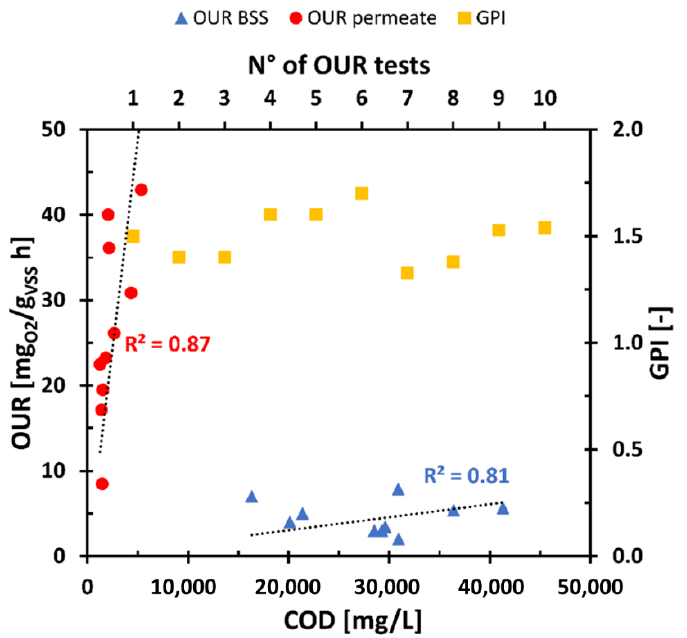
Figure 5. Trend of OUR and GPI. Dot black lines represent the linear fitting of OUR values as a function of COD. Yellow squares indicate the GPI values in ten diverse OUR tests.